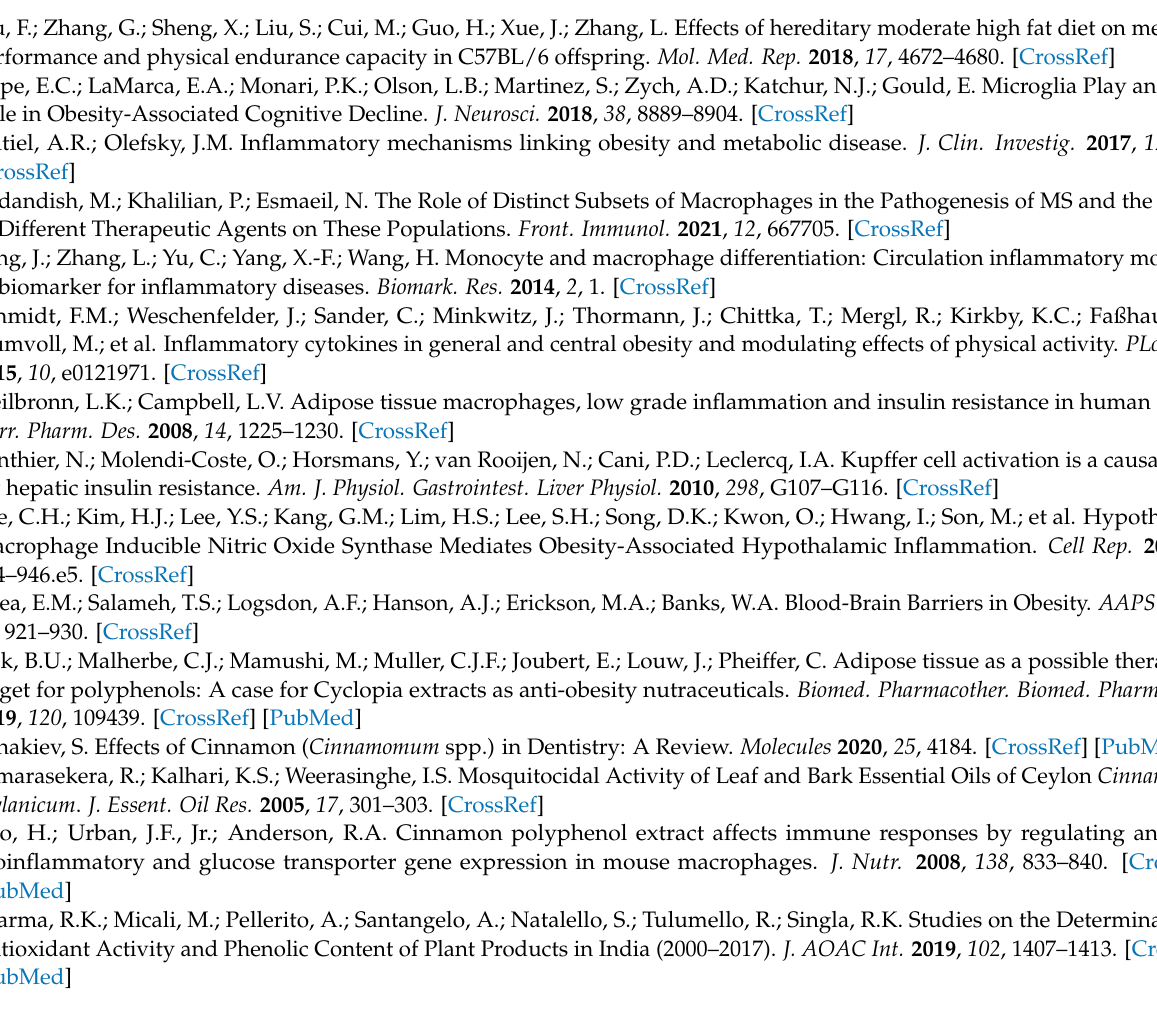
compounds; Table S4: Lipophilicity of cinnamon compounds; Table S5: Water solubility of cinnamon compounds; Table S6: Pharmacokinetics of cinnamon compounds; Table S7: Molecular docking binding affinity of cinnamon components to TNF- α , MIF from M1 macrophage, and MMP-12